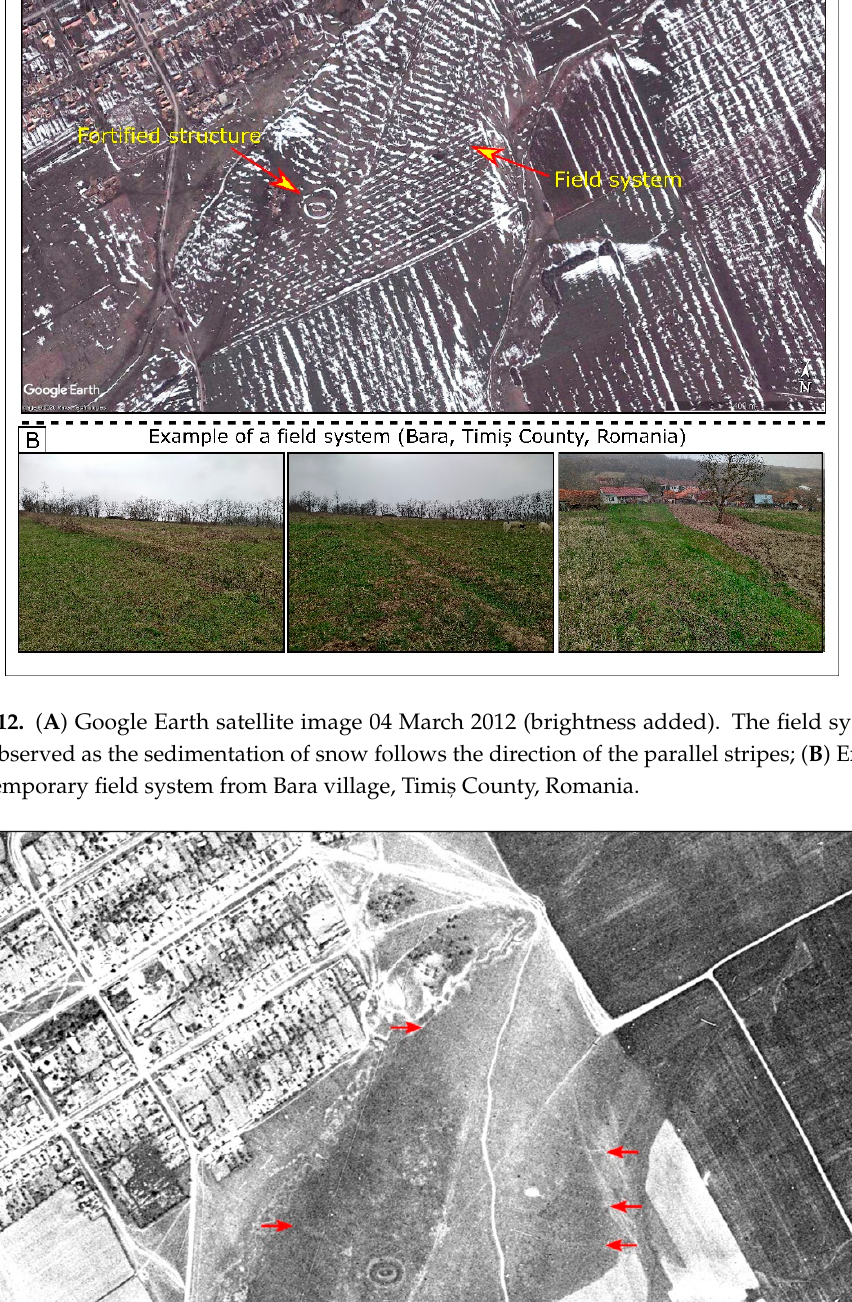
Figure 11. Integration of results of structure from motion (SfM) and magnetometry in combination with DEM: A . Digital surface model—red arrows indicate the field system of the medieval village; black grouped arrows indicate the former modern ploughing lines; the yellow dashed line represents the limit between the former ploughing area and pasture land; the black dashed lines represent the boundaries of the medieval village highlighted by the vegetation. B . The digitization of the field system superimposed on the magnetic map (the dwellings are marked in red).